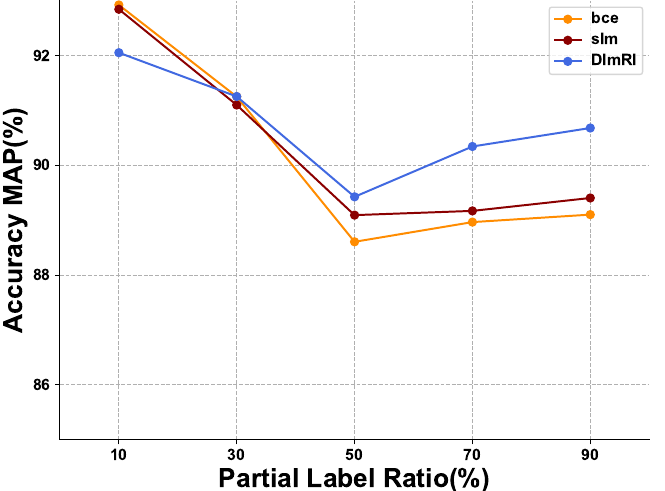
Figure 4. The figure shows the MAP score (%) of three different loss methods on VOC2007 with partial labels. The orange line indicates the accuracy rate using BCE with Logits Loss (bce): the red line indicates the accuracy rate using MultiLabel SoftMargin Loss (slm); and the blue line indicates the accuracy rate using our DlmRl.